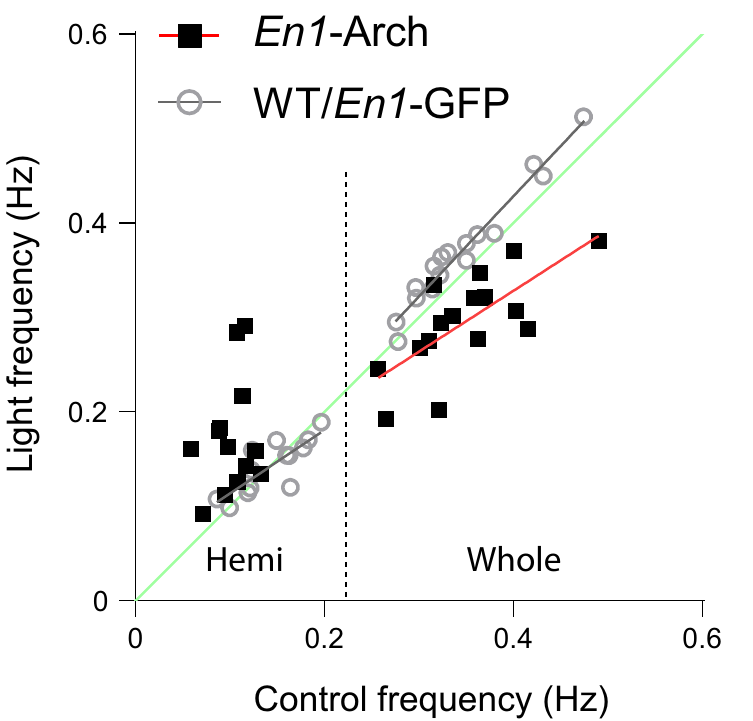
Fig 10. Relationship between the initial frequency and the effect of the light in En1 -Arch and WT/ En1 -GFP preparations during rhythmic activity evoked by NMDA, 5-HT, and DA. Plot showing the frequency of the rhythm evoked by NMDA, 5-HT, and DA before the light (Control frequency) plotted against the frequency of the rhythm during the light (Light frequency) in En1 -Arch (black squares) and WT/ En1 -GFP (gray circles) cords. The green line represents the line of unity, in which the frequency is the same before and during light. The red line is the linear regression calculated for the En1 -Arch experiments in whole cords, whereas the gray lines are the linear regressions calculated separately for the whole cords and hemicords from WT/En1-GFP animals. The hemisected data and the whole-cord data are separated by the dotted line. WT/ En1 -GFP (hemicord n = 13; Spearman correlation r = 0.9009 p = 0.001, slope: 0.6694x + 0.04695; whole cord n = 16; Spearman correlation r = 0.9788 p < 0.0001, slope: 1.062x + 0.003816); En1 -Arch (hemicord n = 13; Spearman correlation r = 0.2469 p = 0.4162; whole cord n = 16; Spearman correlation r = 0.7213 p = 0.016, slope: 0.6439x + 0.07074). Difference between the slopes: WT/ En1 -GFP whole-cord slope versus En1 -Arch whole-cord slope (F[1, 28] = 5.470, p = 0.0267). The data underlying this figure can be found